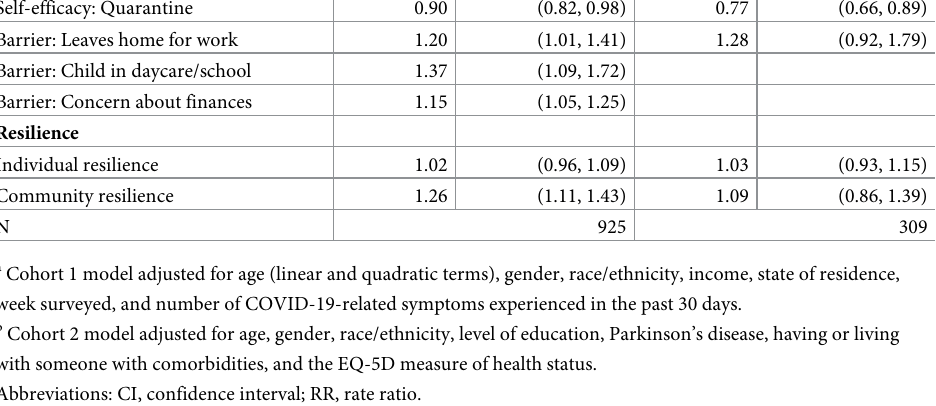
a Cohort 1 model adjusted for age (linear and quadratic terms), gender, race/ethnicity, income, state of residence, week surveyed, and number of COVID-19-related symptoms experienced in the past 30 days. b Cohort 2 model adjusted for age, gender, race/ethnicity, level of education, Parkinson’s disease, having or